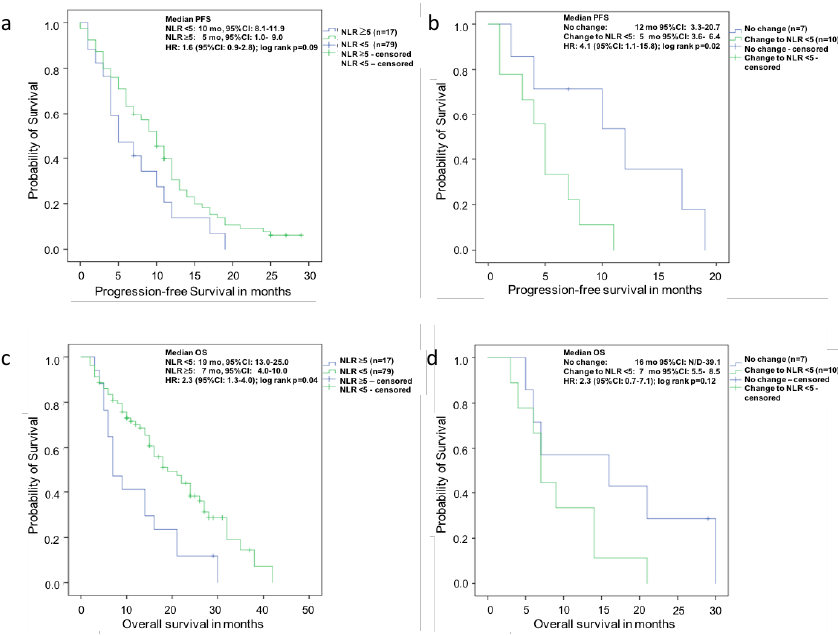
Figure 1. Kaplan-Meier analysis for progression-free survival probability of patients with mCRPC under therapy with Abiraterone ( a ) with baseline neutrophil-to-lymphocyte ratio (NLR) < 5 vs. ≥ 5; ( b ) Patients with or without change of NLR to <5 after eight weeks of therapy and ( c ) overall survival probability with baseline NLR < 5 vs. ≥ 5; and ( d ) patients with or without change of NLR to <5 after eight weeks of therapy.